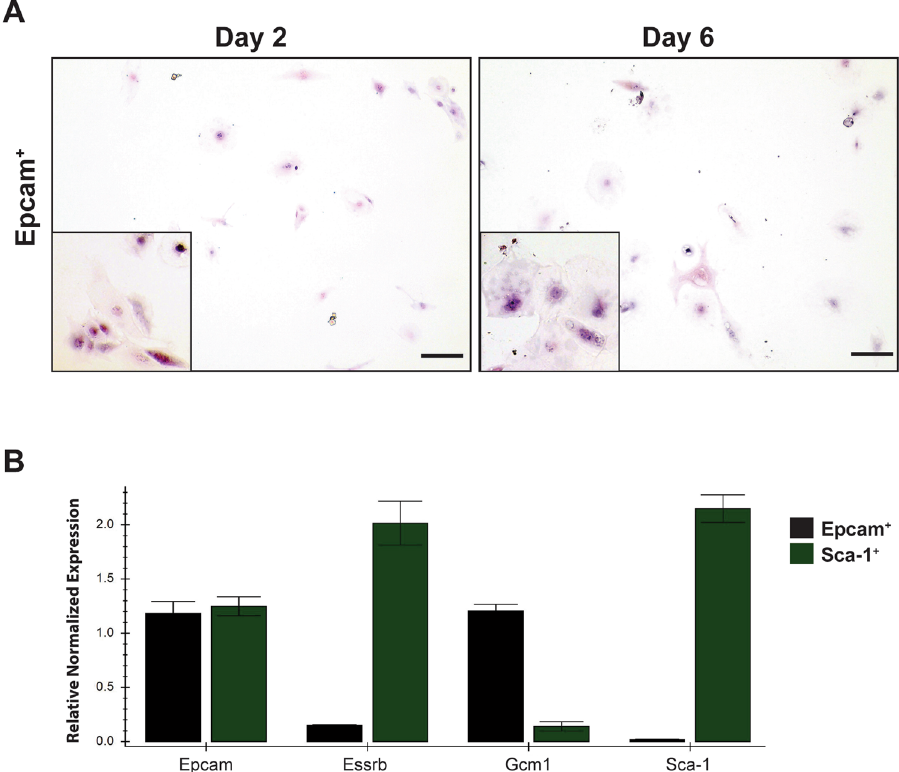
Figure 5. Epcam + trophoblast isolated from TS cell cultures and re-plated in TS media containing growth factors to promote proliferation formed small colonies after 2 days of culture but did not proliferate ( A , compare Day 2 to Day 6). After 6 days in culture in TS media plus growth factors, the cells had not expanded and had the morphology of differentiated trophoblast, with large nuclei and cell bodies (compare Day 6 to Fig. 3, Day 2). Sca-1 + cells compared to Epcam + cells displayed increased expression of the TS cell marker, Esrrb while Epcam + cells expressed the syncytiotrophoblast marker, Gcm1 but not Sca-1 or Esrrb ( B ). Insets in ( A ) show morphology of plated Epcam + trophoblast cells at high magnification (400x). Cells were stained with hematoxylin and eosin. Scale bar = 500